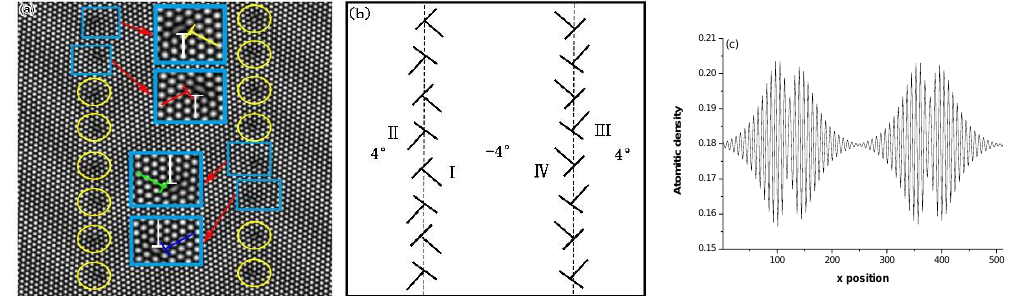
Figure 2. ( a ) The dislocations structure in the Symmetric tilt grain boundary (STGB) in bicrystal system designed by PFC method. Inset: the dislocation configuration of the blue box area; ( b ) Schematic of the oblique dislocation arrangement (here the vertical dislocation arrangement is ignored, in order to highlight the slip motion of dislocations, which would be really helpful to understand the following results) in the STGB with four kinds of the dislocation I, II, III and IV; ( c ) The average spatial distribution of the order parameter of the atomic density inside the sample projects to x axis. In Figure 2a, the yellow circle areas indicate the place where there are dislocations in the GB, while the blue boxes indicate the magnified areas with the dislocation region and give the